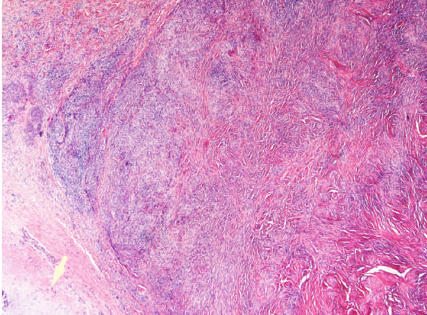
Figure 2: Massive fibrosis in a storiform pattern. Areas of accu- mulation of plasma cells. Destruction of normal mucosal structure. Cartilage from the nasal septum in the left bottom corner (arrow). HE ×